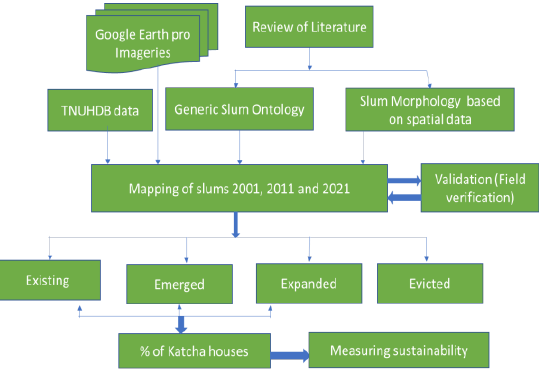
Figure 2. Methodology